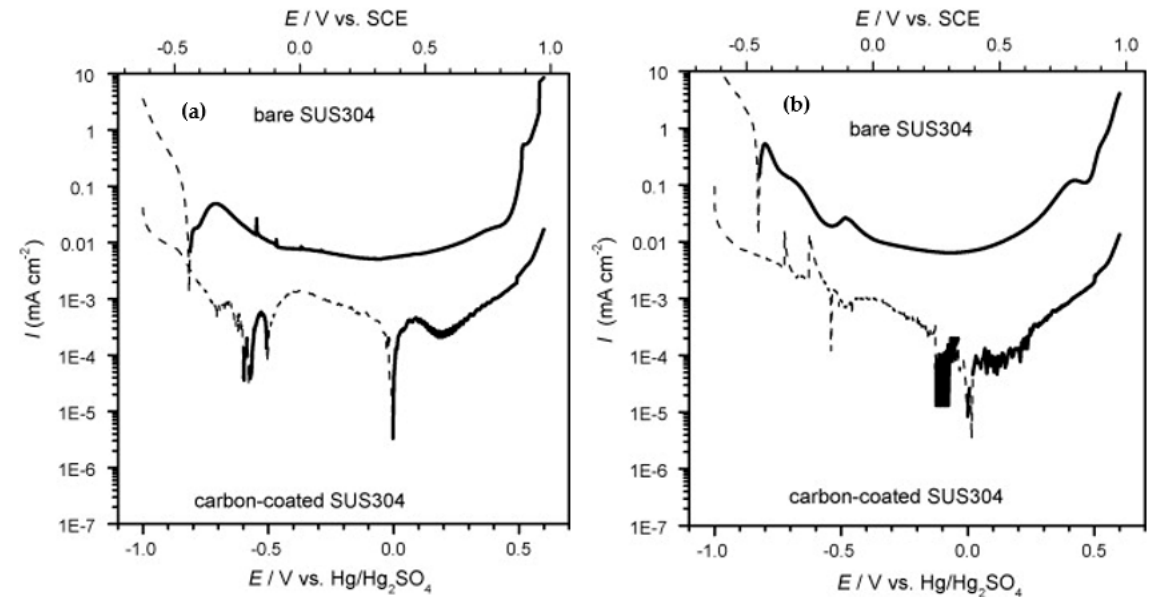
Figure 14. Comparison of corrosion behavior of steel in 0.5 M H 2 SO 4 at 80 °C without ( a ) and with 2 ppm HF ( b ). Reprinted from [77] copyright (2007), with permission from Elsevier.